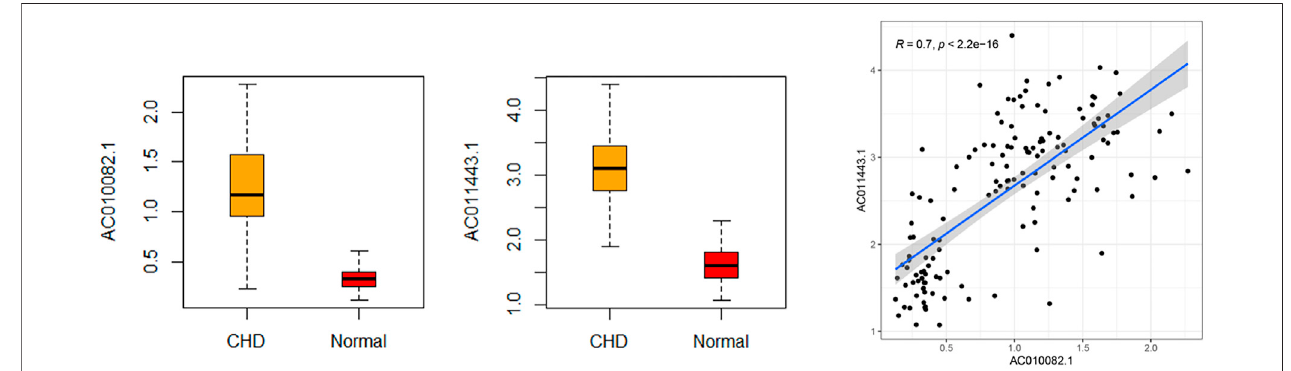
FIGURE 9 | Relative expression level and correlation of AC010082.1 and AC011443.1 based on GEO database.